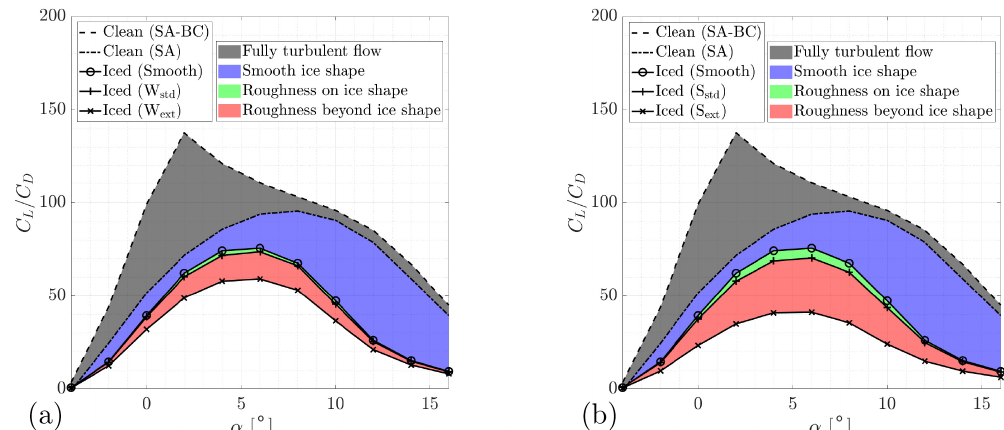
Figure 22. Lift-to-drag ratio of Section B considering different cases. Lines represent airfoil efficiency in various cases. Shaded areas represent different contributions to loss in efficiency, providing a qualitative superposition of effects. (a) k s /c = 0 . 34 × 10 − 3 . (b) k s /c = 3 × 10 − 3